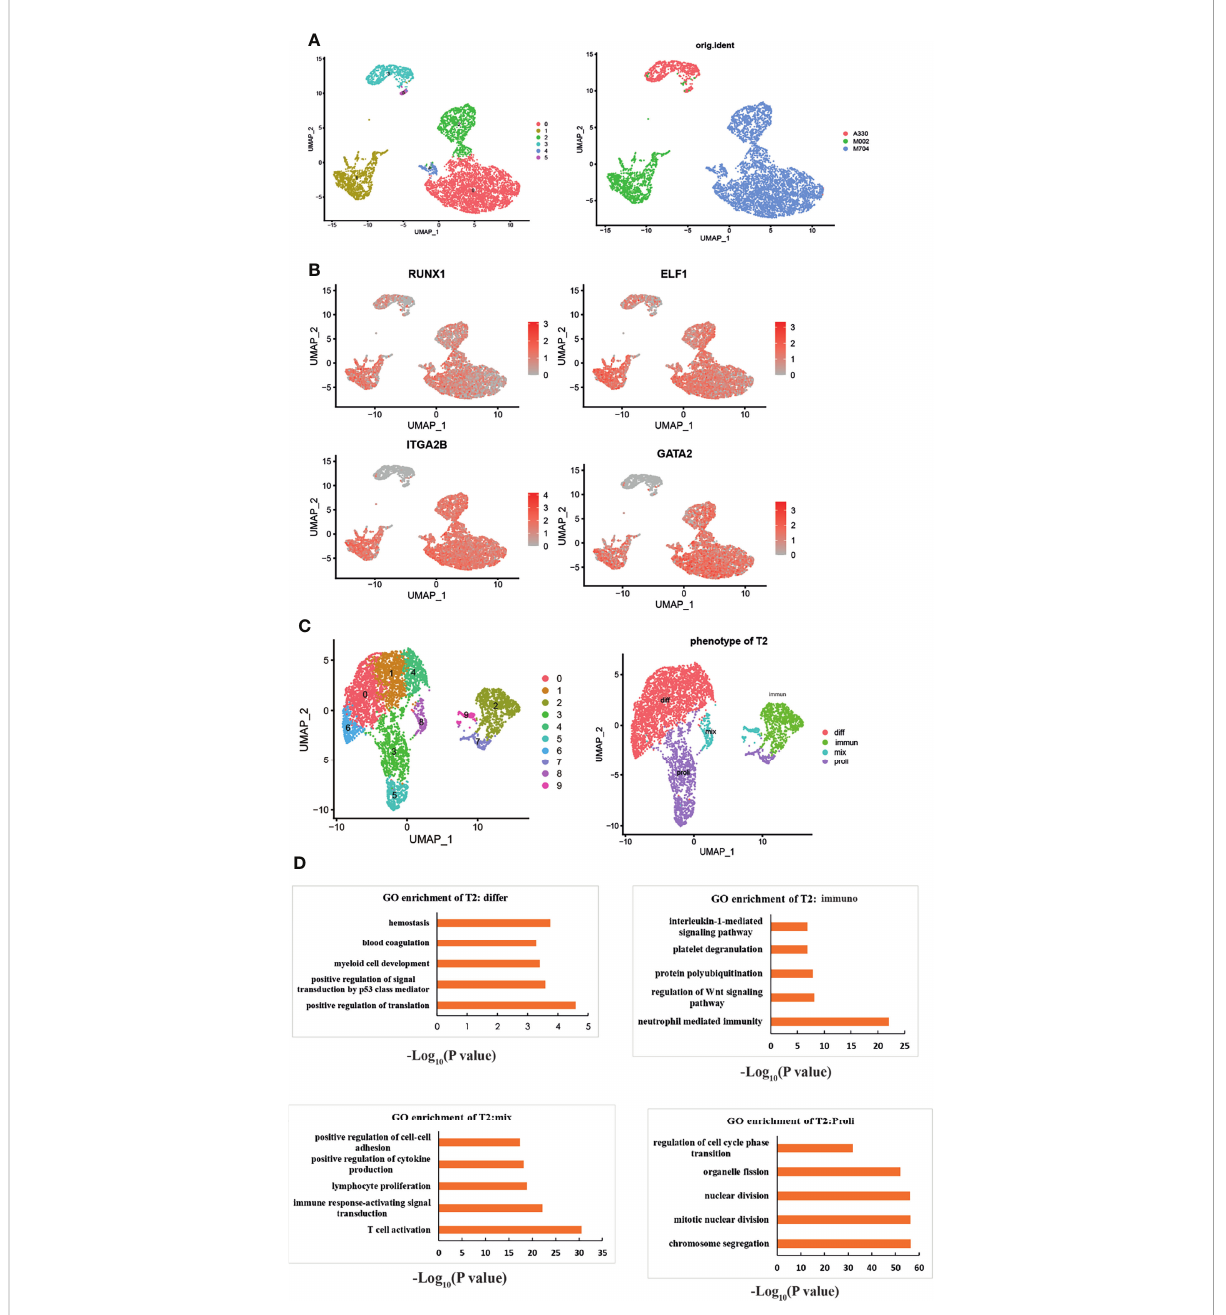
FIGURE 2 The intratumoral heterogeneity of abnormal megakaryoblasts. (A) The UMAP plots show six subclusters in the three samples. (B) UMAP plots showing the expression of the signature genes following the MK lineage. The distinct malignant cell types of immature-like T1 cells (highly expressed MK ’ s markers but not mature markers like ITGA2B) and mature-like T2 cells (highly expressed all MK ’ s markers especially mature markers like ITGA2B) were identi fi ed. The red color means the genes are highly expressed, and gray means low or not expressed. (C) UMAP visualization of four different phenotypes among T2. “ Differ ” refers to differentiation, “ immune ” refers to immunity, “ mix ” refers to mix lineages, and “ proli ” refers to proliferation. (D) The GO enrichment plots of each phenotype of T2. All enriched pathways and biological processes are under a p-value of 0.05 and correction of